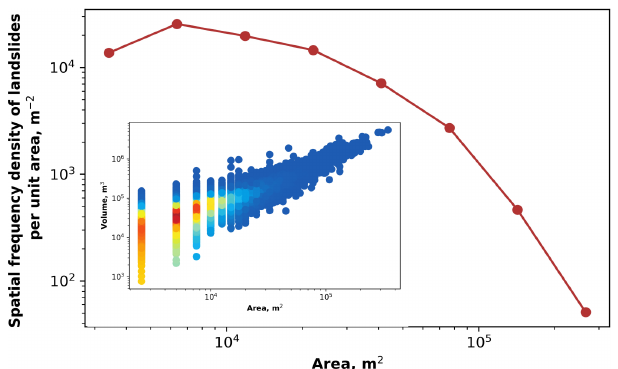
Figure 14. Magnitude–frequency relationship of the landslides sim- ulated with Landlab-HyLands (red dots) and illustrated in Fig. 13. The inset shows a scatter density plot showing the simulated area– volume relationship.